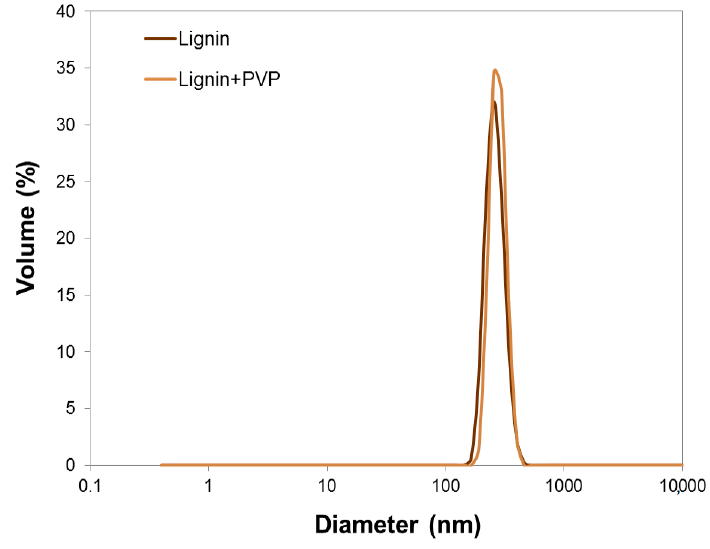
Figure 3. Particle size distributions by volume of the lignin and lignin + PVP samples.